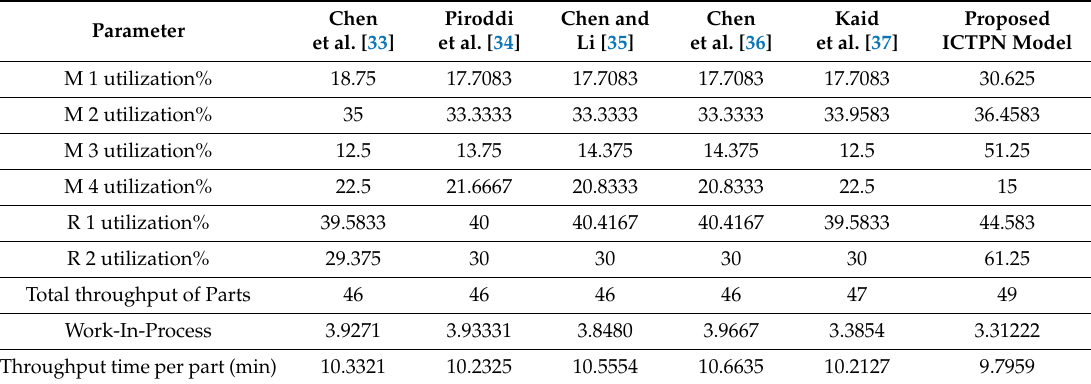
Table 2. Time performance comparison with the existing